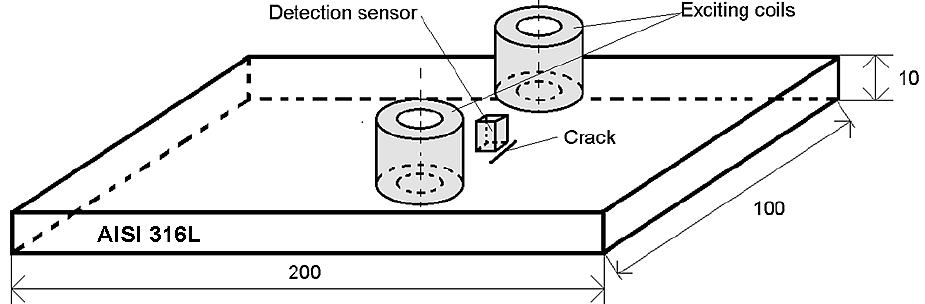
Figure 6. Spatial configuration of the plate specimen and the ECT probe (dimensions are in mm).